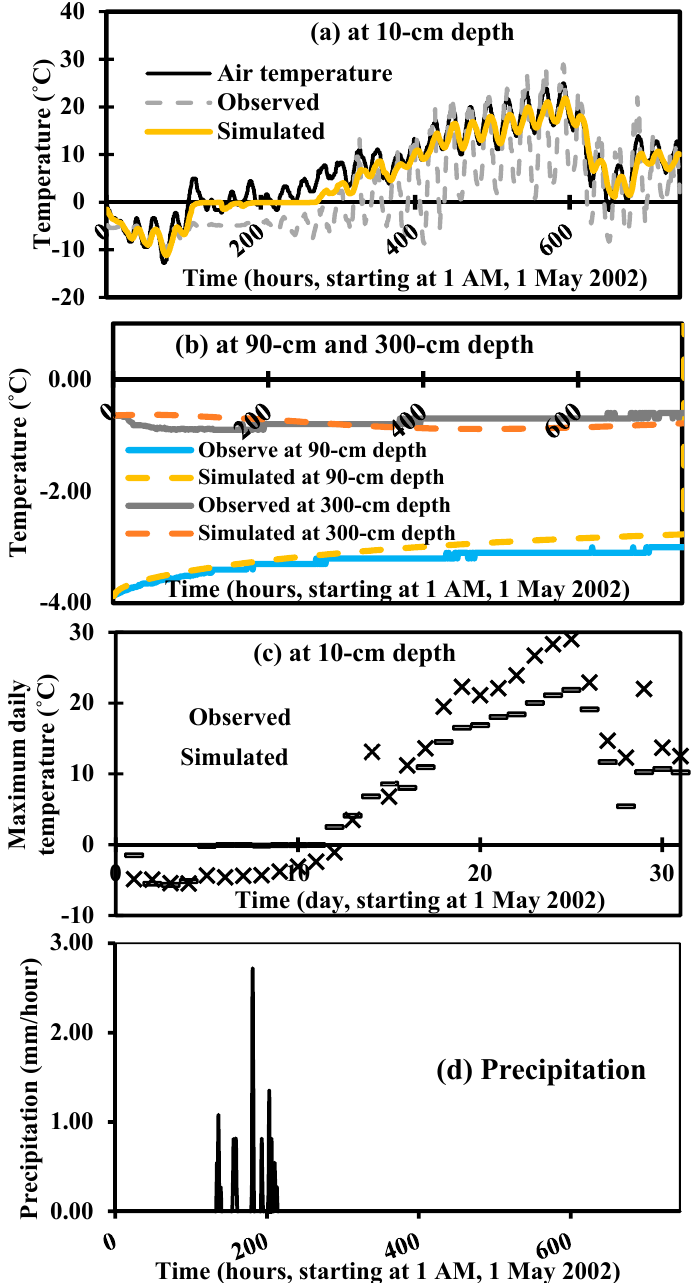
Figure 6. Time-series of observed and simulated temperature at: ( a ) 10-cm depth, ( b ) 90-cm and 300-cm depths and ( c ) maximum values at 10-cm depth, ( d ) corresponding hourly precipitation rate.